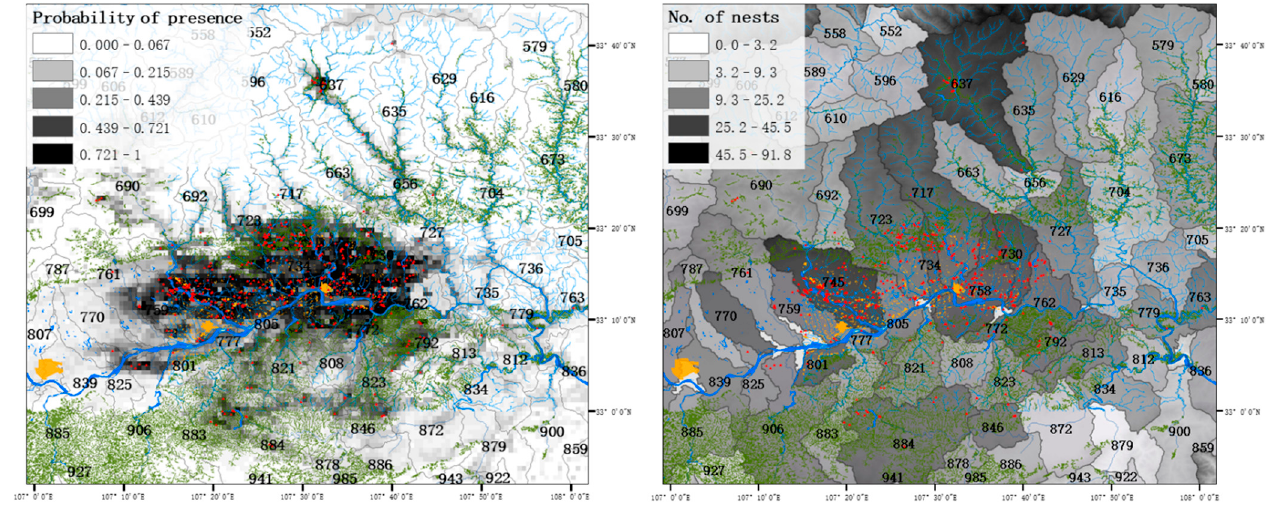
Figure 4. Predicted probability of presence of nests in every 1 km 2 quadrat (left panel) and predicted number of nests in every watershed based on the nest data in 2019 using the random forest algorithm (right panel). The probability of presence was summed in every watershed to represent number of nests. The red triangles are nest sites. The polygons in grey colors are watersheds; the green areas represent rice paddies; the blue areas represent water bodies (rivers, lakes, and ponds); and the brown areas are human residences.